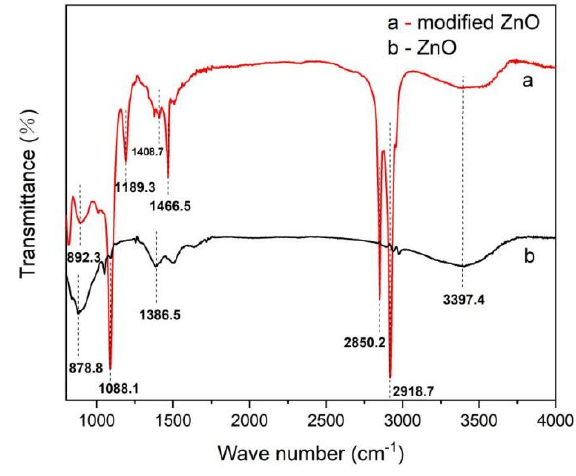
Figure 5. Infrared spectra of nano-ZnO before and after modification.